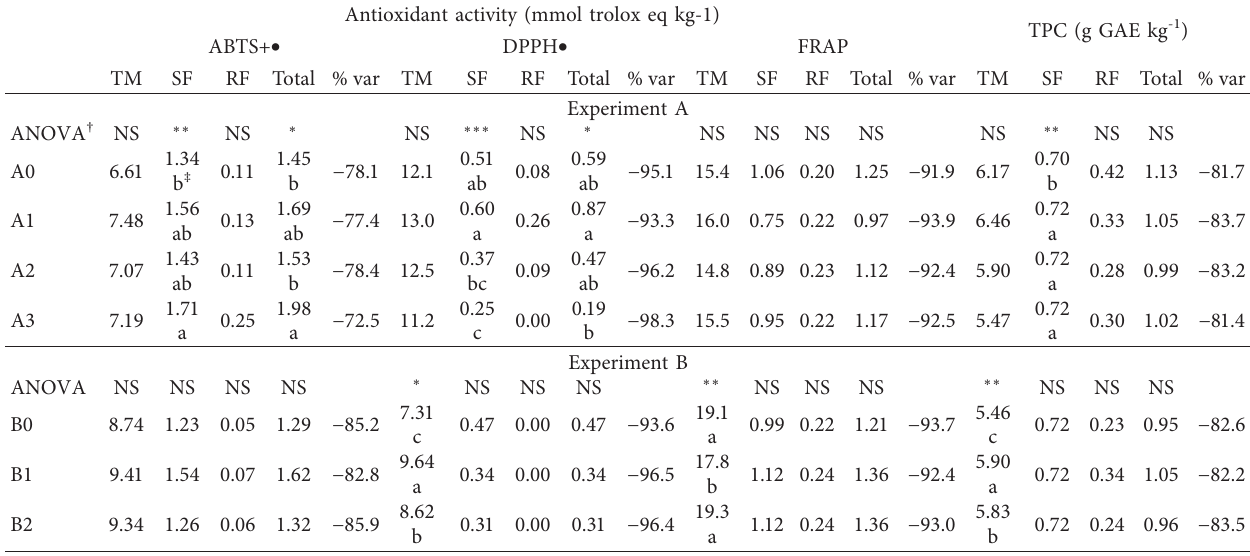
Table 2: Antioxidant activity (ABTS+ • , DPPH, and FRAP) and Total Phenolic Content (TPC) of “Manzanilla” table olives before and after gastrointestinal in vitro simulation digestion of experiment A and experiment B.